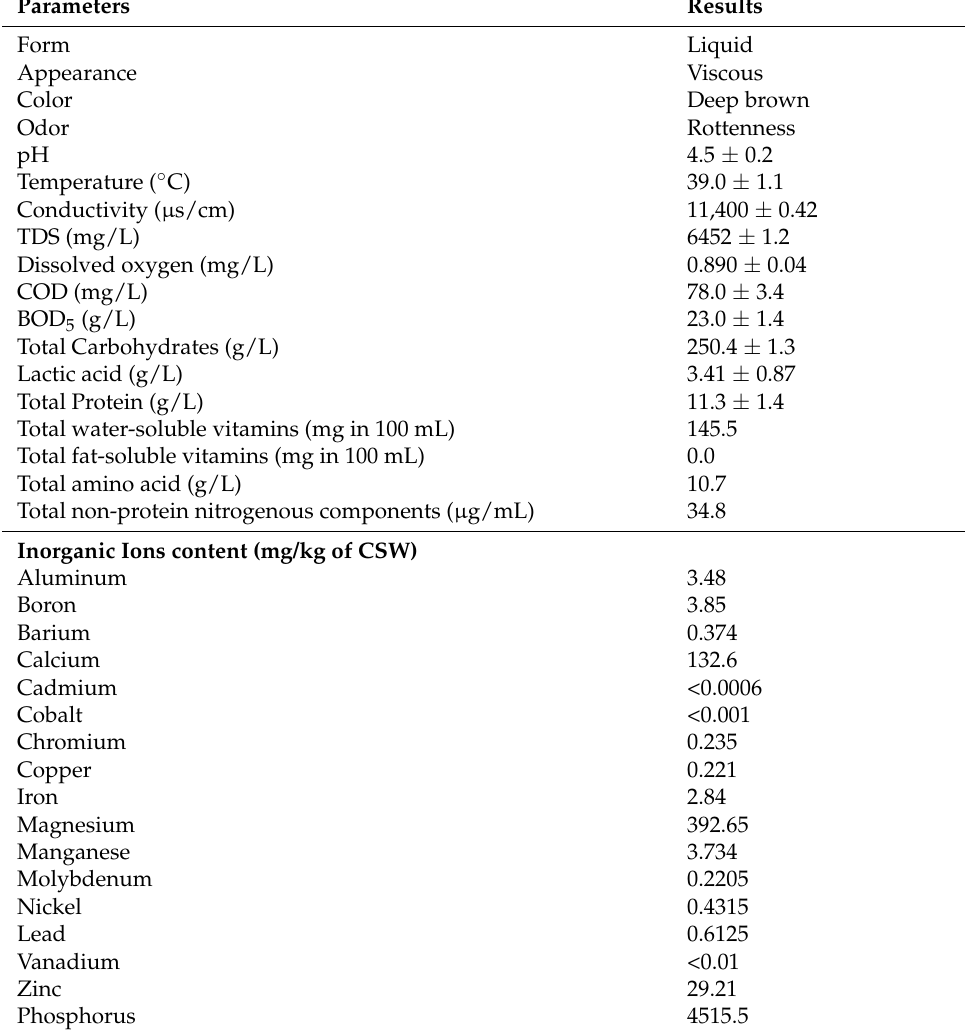
Table 1. Physicochemical characterization and inorganic ions content of CSW used in the cur- rent